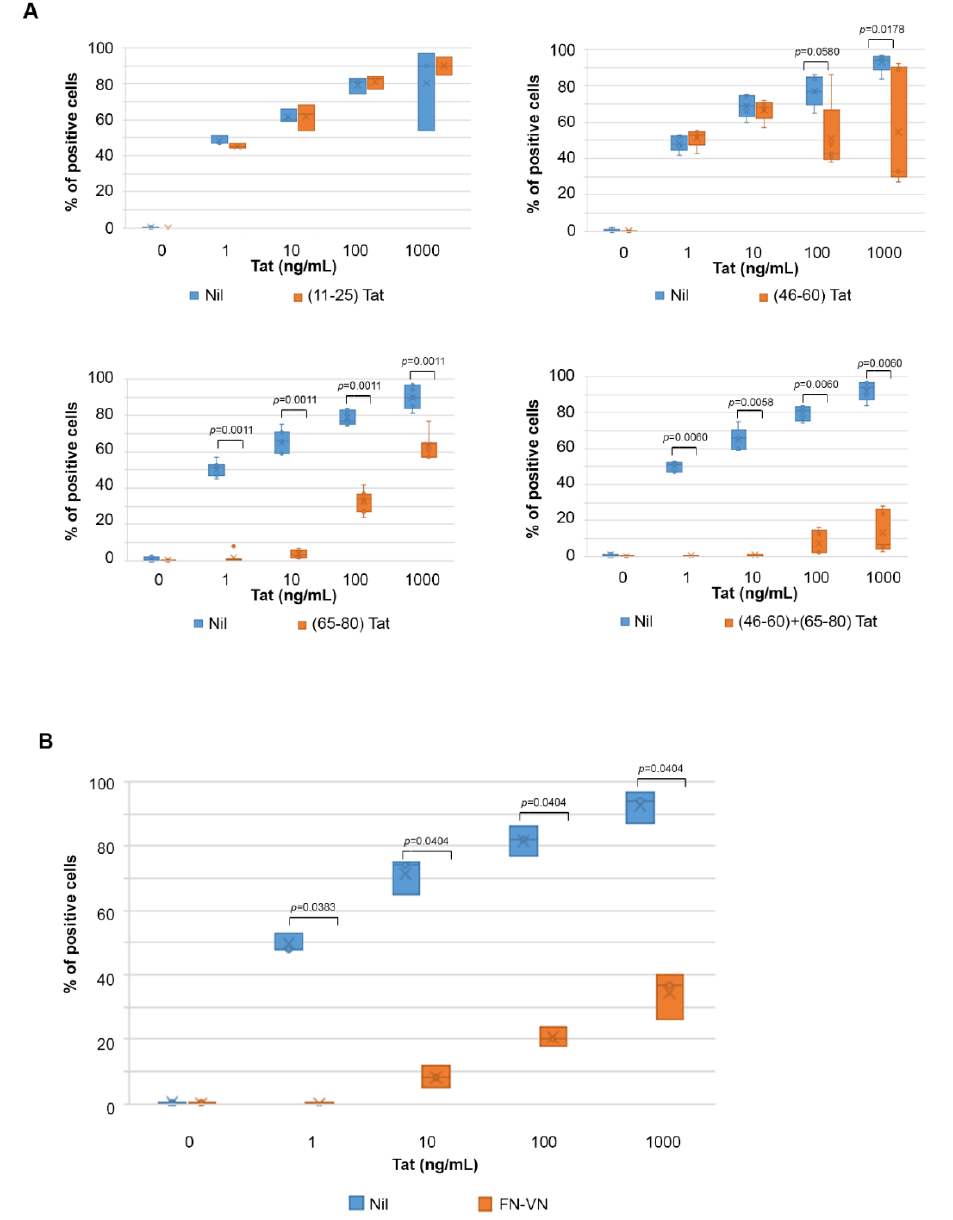
Figure 3. Role of Tat arginine-glycine-aspartic acid (RGD) and basic region in entry of Tat in IC-HUVEC, and entry blockade by fibronectin and vitronectin. In ( A ), IC-HUVEC were incubated for 2 h with 100 μg/mL of the (11–25) Tat-ACIDIC (upper left panel), (46–60) Tat-BASIC (upper right panel), (66–80) Tat-RGD (lower left panel) or combined (46–60) Tat and (66–80) Tat (lower right panel) peptides. Cells incubated with the peptide suspension buffer (PBS-0.1% BSA) were employed as controls. In ( B ), IC-HUVEC were incubated for 2 h with fibronectin (FN) and vitronectin (VN), combined at 50 μg/mL each. FN and VN dilution buffer (PBS-0.1% BSA) served as a negative control (Nil). For both ( A , B ), after pre-incubation, IC-HUVEC were exposed for 10 min to biologically active Tat (1–1000 ng/mL) or its suspension buffer (Nil). Intracellular Tat content was assessed by intracellular staining and flow cytometry as described in the legend to Figure 1. Results are expressed as the percentage of positive cells as compared to isotype-stained samples and non-permeabilized cells. Box-plot data obtained from three to six independent experiments and analyzed by the Mann–Whitney test are shown. Dots in box-plots indicate individual measures. Orange plots refer to IC-HUVEC incubated with Tat peptides ( A ) or combined FN and VN ( B ); blue plots refer to control IC-HUVEC.